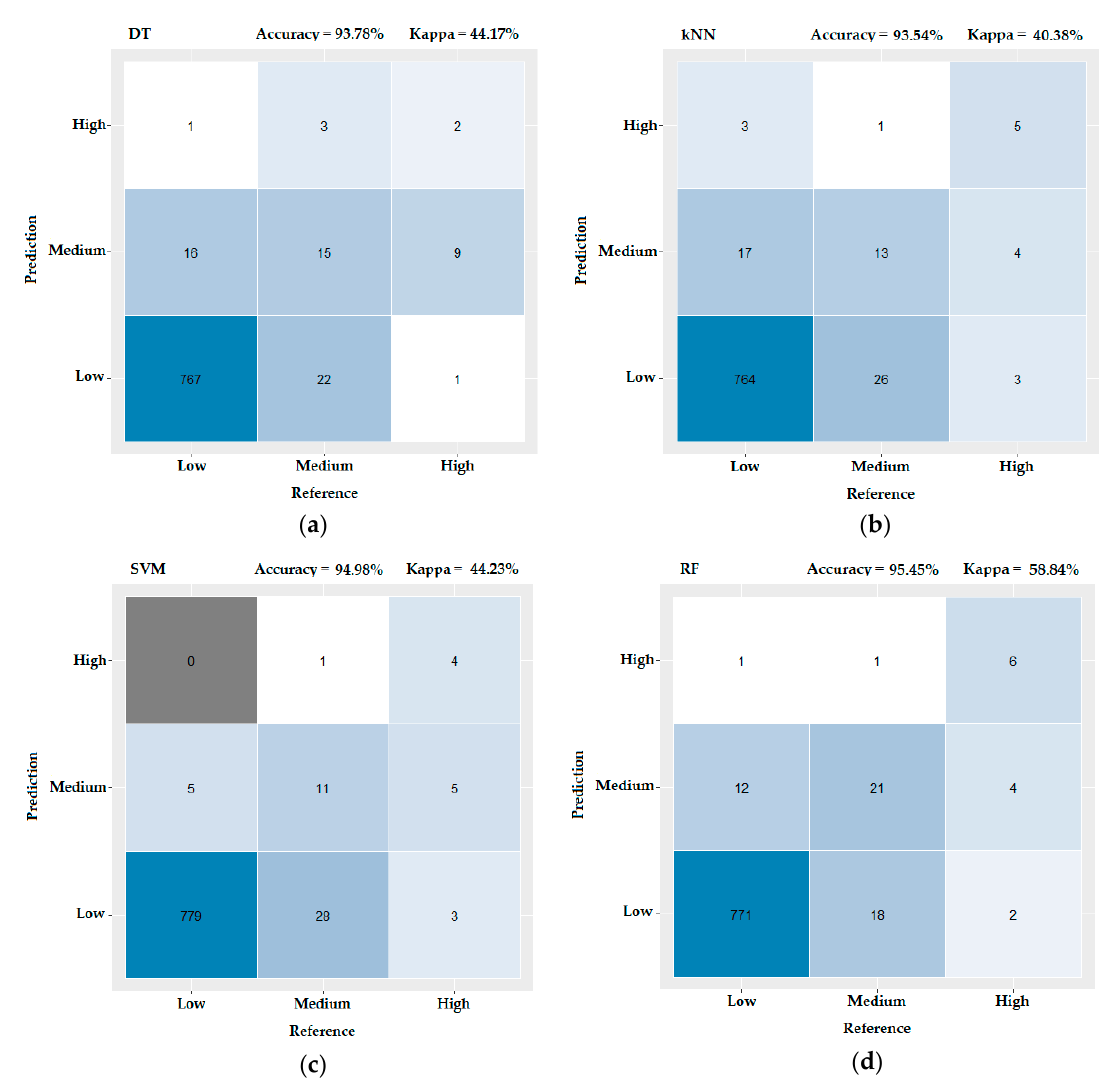
Figure 6. Confusion matrices for Distance Tree (DT), K-Nearest Neighbor (k-NN), Support-vector machine (SVM) and Random Forest (RF). On top of each matrix the performance indices—Accuracy and Kappa—are illustrated. ( a ) Results of the DT algorithm, ( b ) results of the k-NN algorithm, ( c ) results of the SVM algorithm and ( d ) results of the RF algorithm.